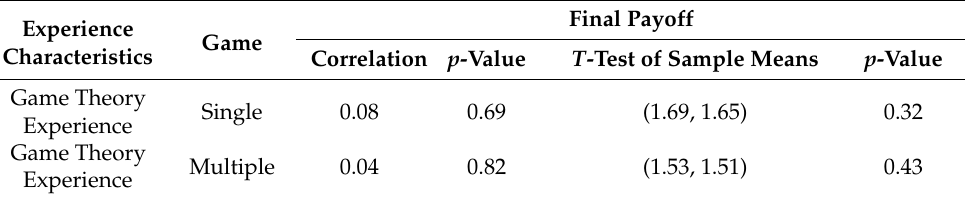
Table 6. Test for a relation between player’s game theory experience and final payoff in each trial game (with single and multiple cores). The T -test brackets show the means with experience and